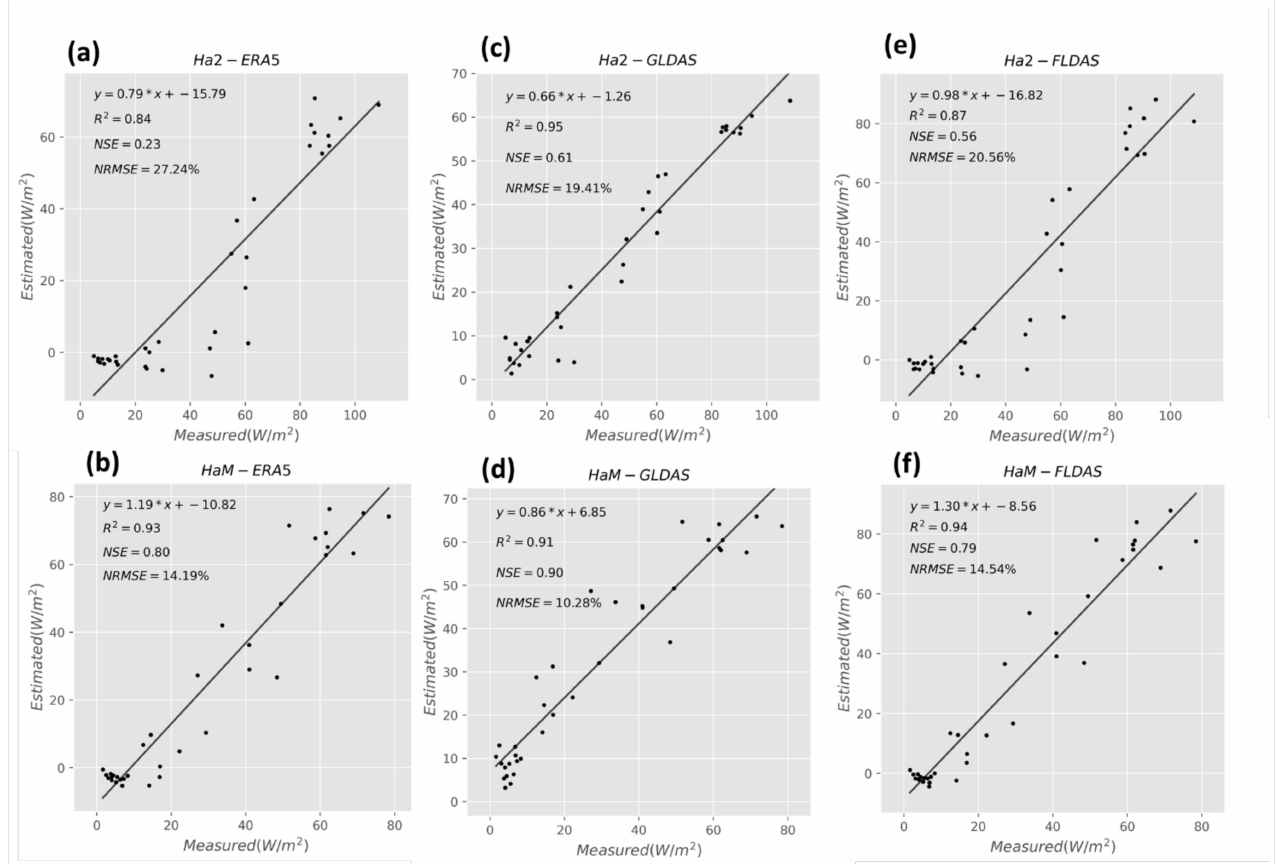
Figure 3. Scatter plots of observations and estimations of latent heat flux using MEP methodology (ERA5: ( a , b ); GLDAS: ( c , d ); FLDAS: ( e , f )).